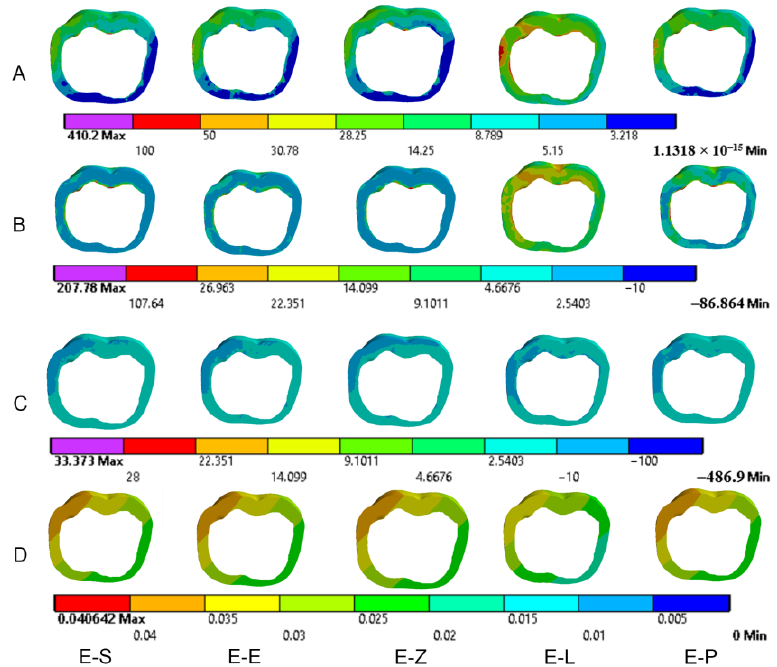
Figure 9. Stress distribution and displacement of enamel in all models under axial loading. ( A ) von Mises stress, ( B ) maximum principal stress, ( C ) minimum principal stress and ( D ) displacement. E-S: zirconia-reinforced lithium silicate ceramic model, E-E: lithium disilicate glass ceramic model, E-Z: translucent zirconia model, E-L: resin nanoceramic model and E-P: polymer-infiltrated ceramic network model.